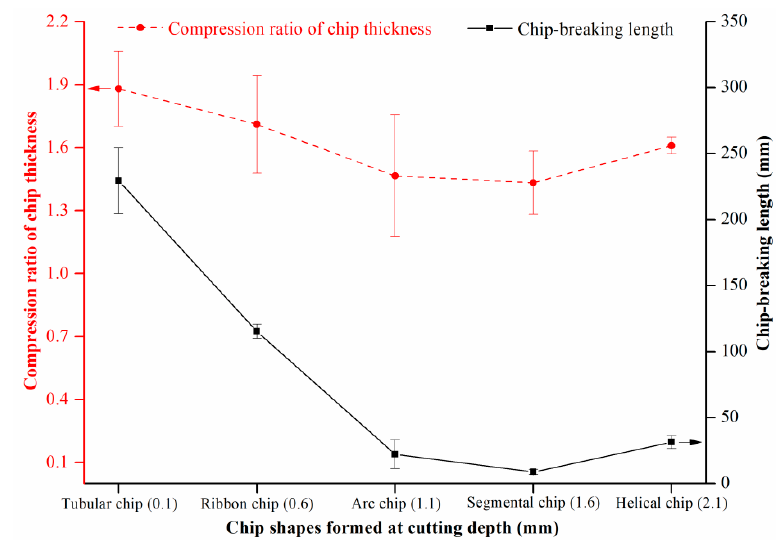
Figure 11. Average values of chip compression ratios and chip-breaking length for different chip shapes; each point is the average of five observations, and the error bars represent one standard deviation.